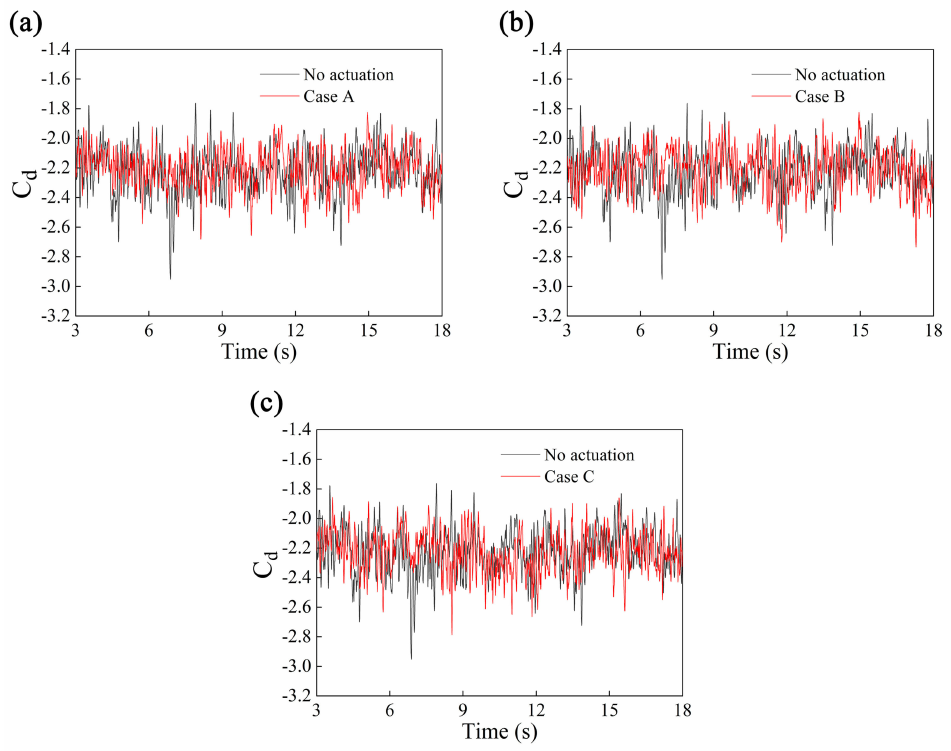
Figure 10. Time histories of drag coe ffi cients: ( a ) no actuation and case A; ( b ) no actuation and case B; ( c ) no actuation and case